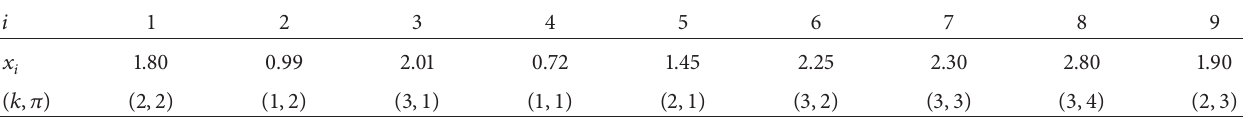
Table 1: Illustration of the decoding process in